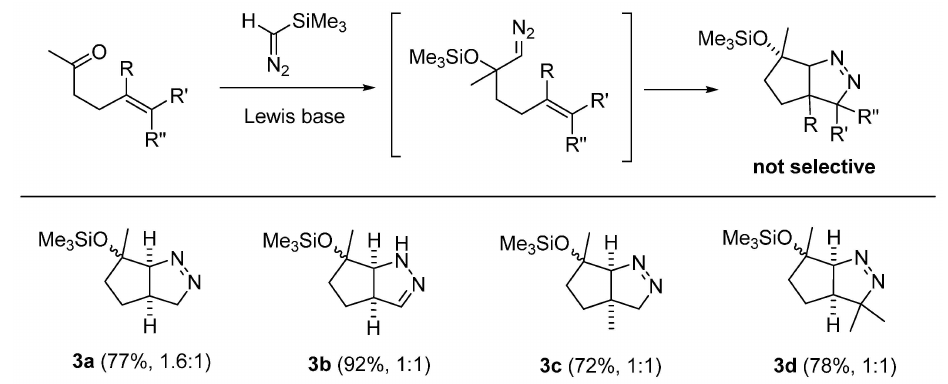
Figure 8. Pyrazolines formed with low diastereoselectivity.